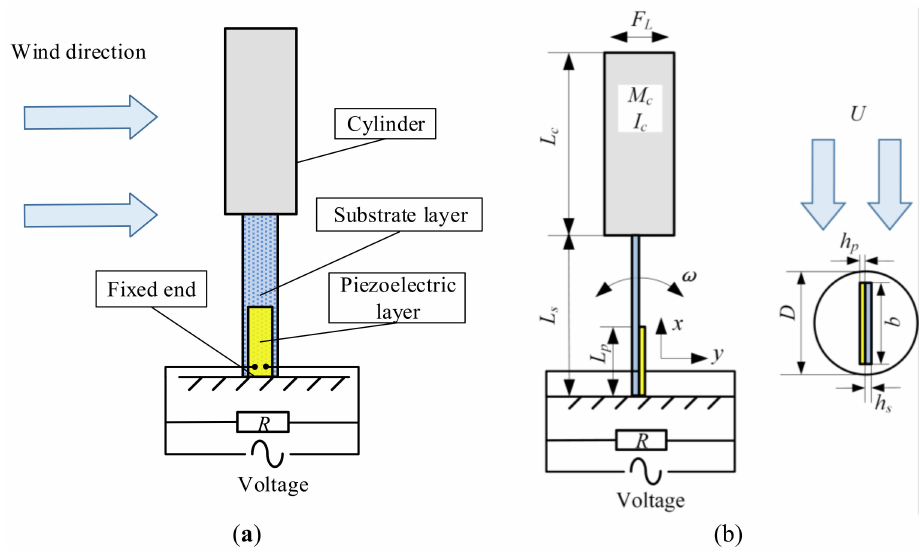
Figure 1. Upright piezoelectric energy harvester (UPEH) energy harvesting system ( a ) composition of UPEH system; ( b ) schematic of